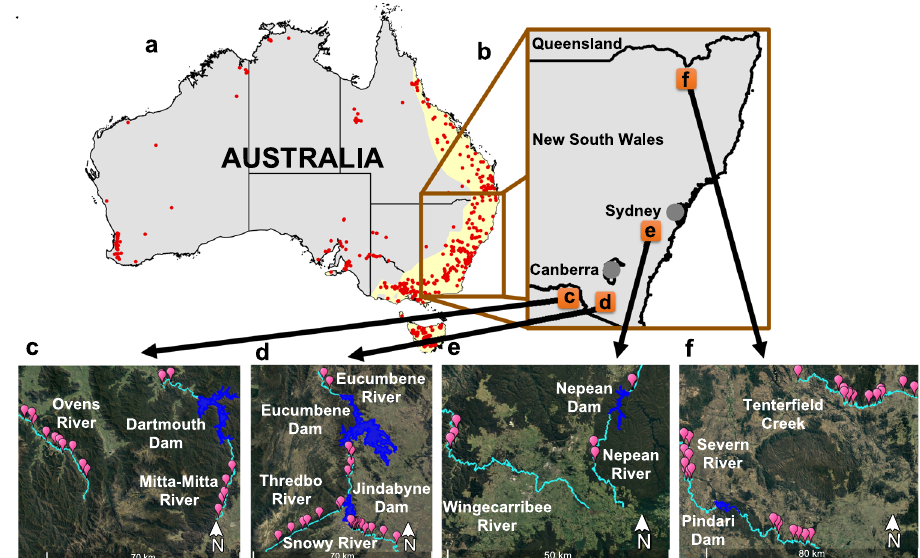
Fig. 1 Sampling sites. a Distribution of major dams (>10 m high; red points) within and outside the IUCN platypus distribution (yellow shade), and the focus regions for this study (brown inset). b Location of rivers in south-east Australia where platypuses were sampled (orange squares) in rivers that were regulated (with major dams) and unregulated (no major dams). c Upper Murray Rivers: Ovens (unregulated) and Mitta-Mitta Rivers (regulated, upstream sections are in the south, con fl uence with Ovens is out of the frame, in northwest). d Snowy Rivers (do not follow the paired experimental design, due to geographic constraints; see methods): Eucumbene (regulated), Thredbo (unregulated), and Snowy River (regulated, Snowy fl ows downstream to the southeast). e Central NSW Rivers: Wingecarribee River (unregulated) and Nepean River (regulated, downstream sections are in the north, there is no con fl uence with Wingecarribee). f Border Rivers: Tenter fi eld Creek (unregulated) and Severn River (regulated, upstream sections are to the east, con fl uence with Tenter fi eld is out of the frame, in northwest). Pink balloons represent the 81 sampling sites; rivers are coloured in light blue, and reservoirs behind major dams are in dark blue. Platypus distribution shape fi le was downloaded from The IUCN Red List of Threatened Species 74 . Rivers and dams shape fi les were downloaded from Geoscience Australia 75,76 . Map of Australia shape fi le was downloaded from Australian Bureau of Statistics 77 . Dams height and GPS coordinates were downloaded from Australian National Committee on Large Dams Incorporated 78